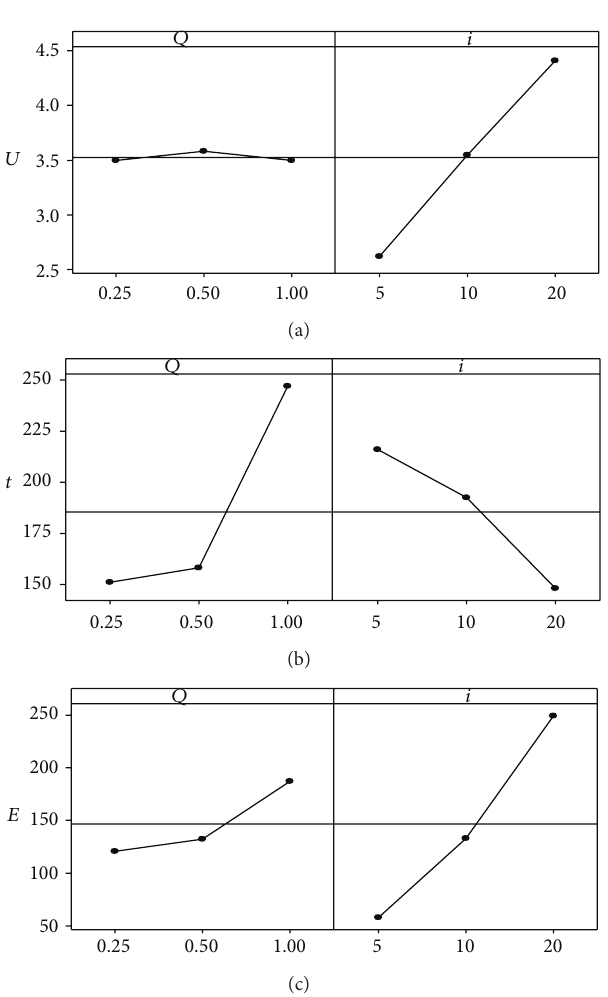
Figure 7: Main effects diagrams of feedwater flow rates 𝑄 (0.25, 0.50, and 1.00 Lmin −1 ) and current densities 𝑖 (5, 10, and 20 Am −2 ) for As electroremoval treatments performed in the EC reactor on the response of (a) 𝑈 , (b) 𝑡 , and (c) 𝐸 .